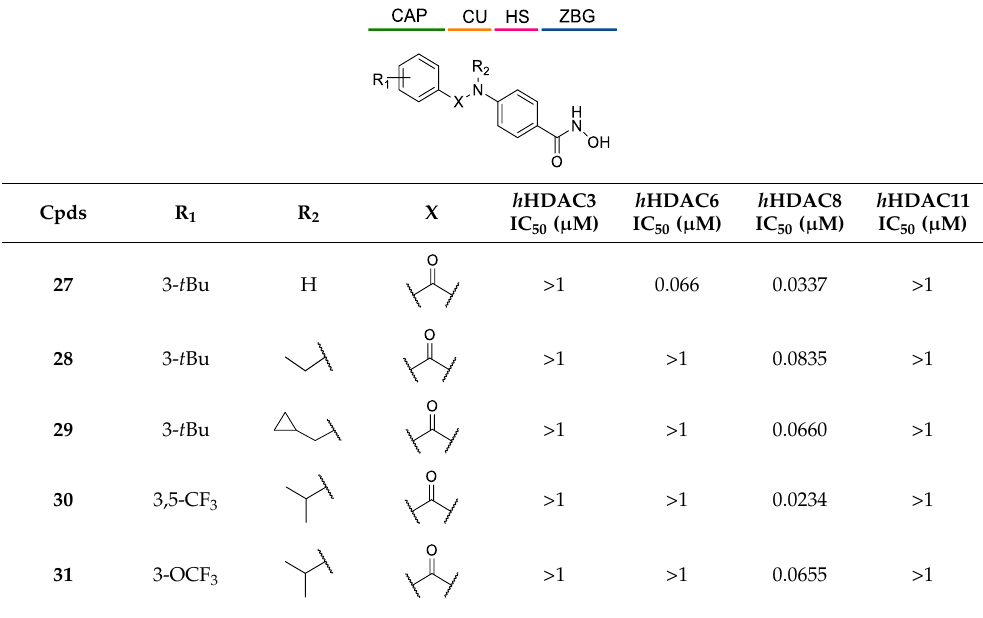
Table 5. General structure and IC 50 values of 27 , 28 , 29 , 30 and 31 [24].